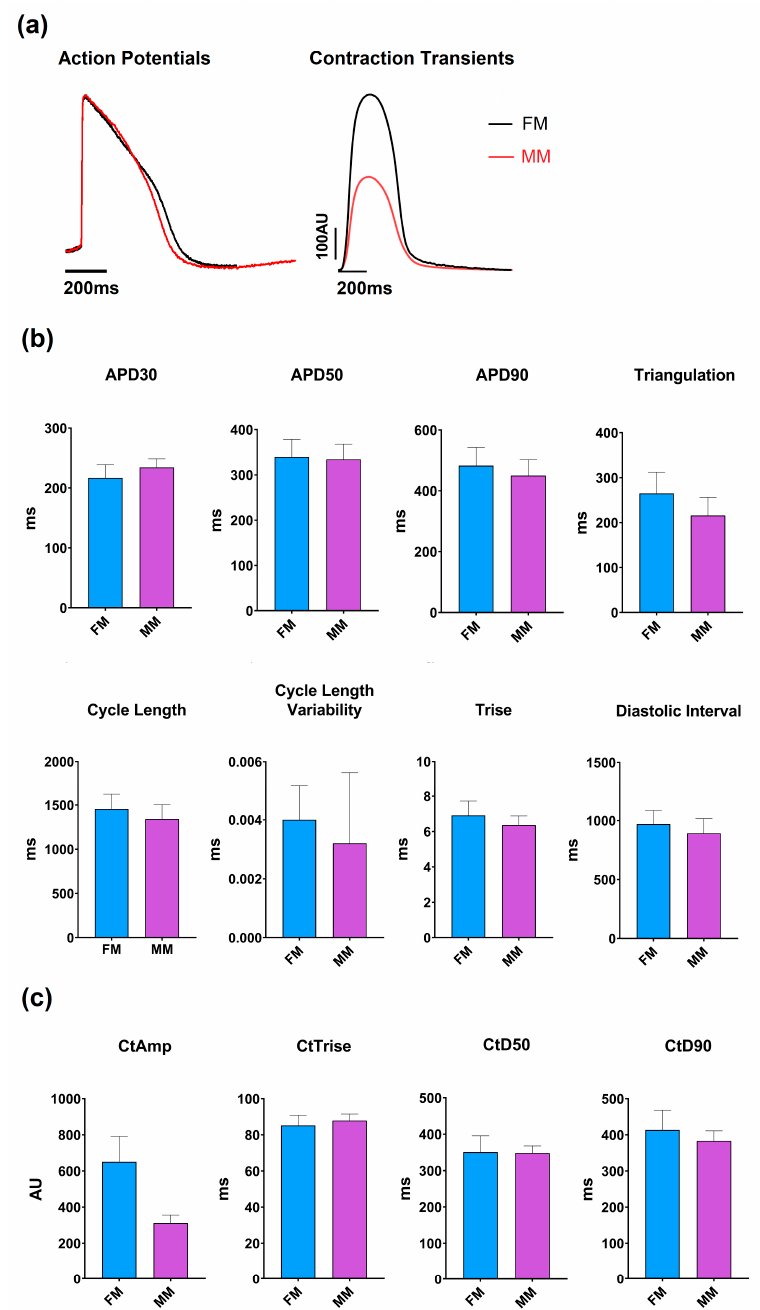
Figure 2. Overview of the models’ base parameters. ( a ) Example traces of the two models are shown for the voltage dye ( left ) and contractility ( right ) recordings: monolayer model with fibronectin (FM) (blue) and Matrix Plus coated plates (MM, violet). ( b ) Mean ± SEM of the key electrophysiological biomarkers; ( c ) Mean ± SEM of the key contractility